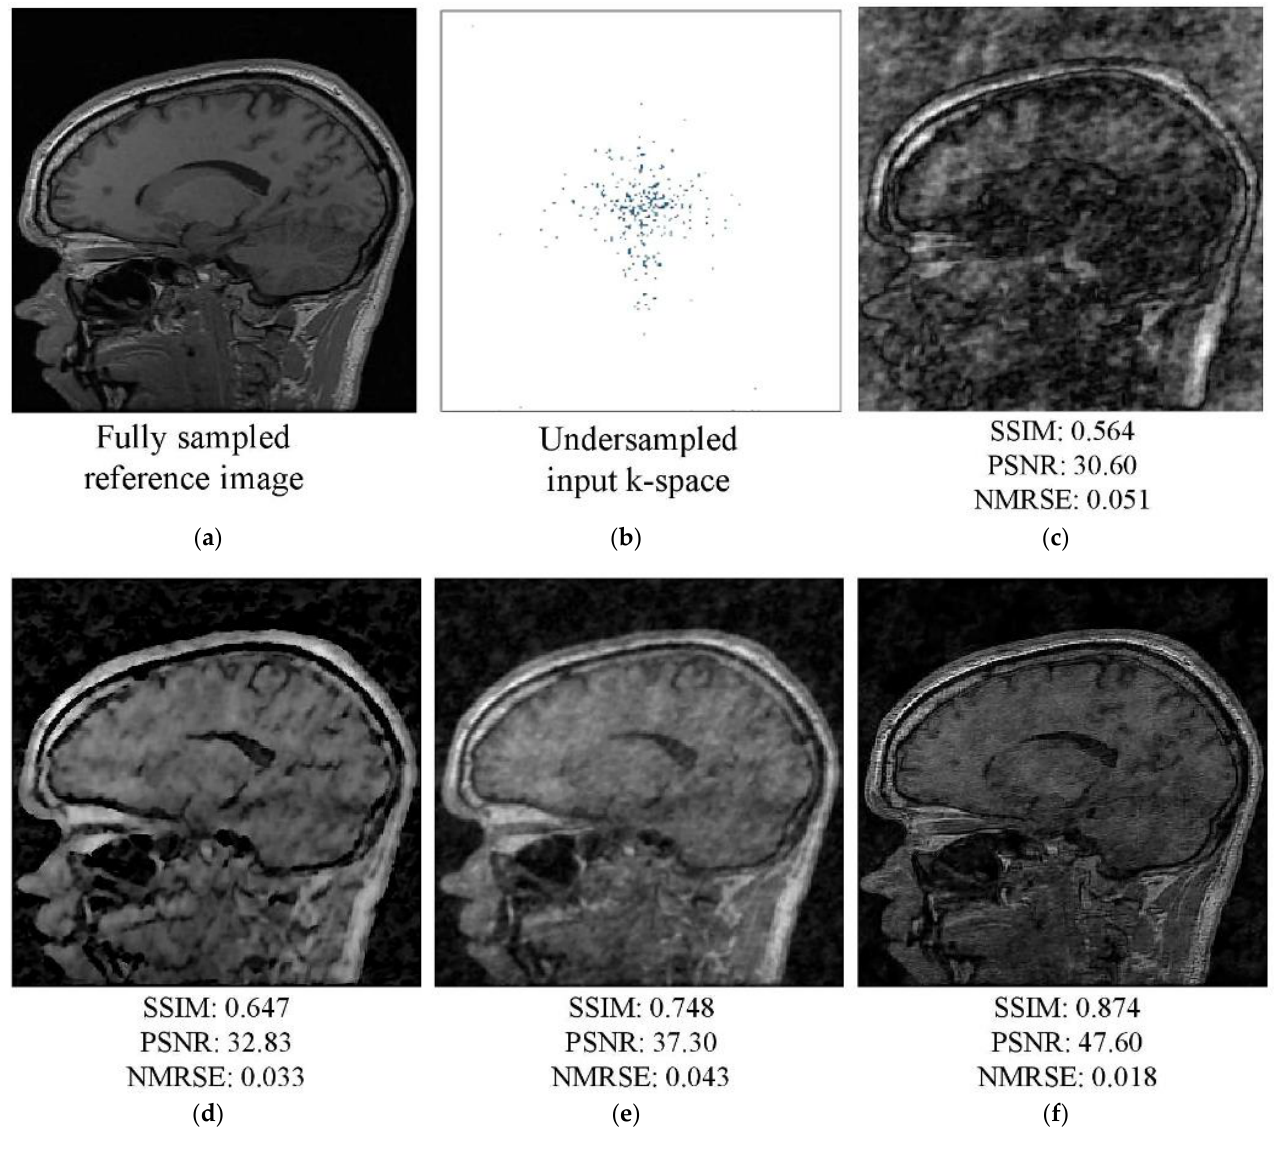
Figure 9. MRI images from the test dataset (slice No. 100) for AF 6: ( a ) fully sampled reference image and ( b ) undersampled k-space. Image reconstructed by the ( c ) IFFT, ( d ) Unet, ( e ) W-net, and ( f ) RA-CNN methods.